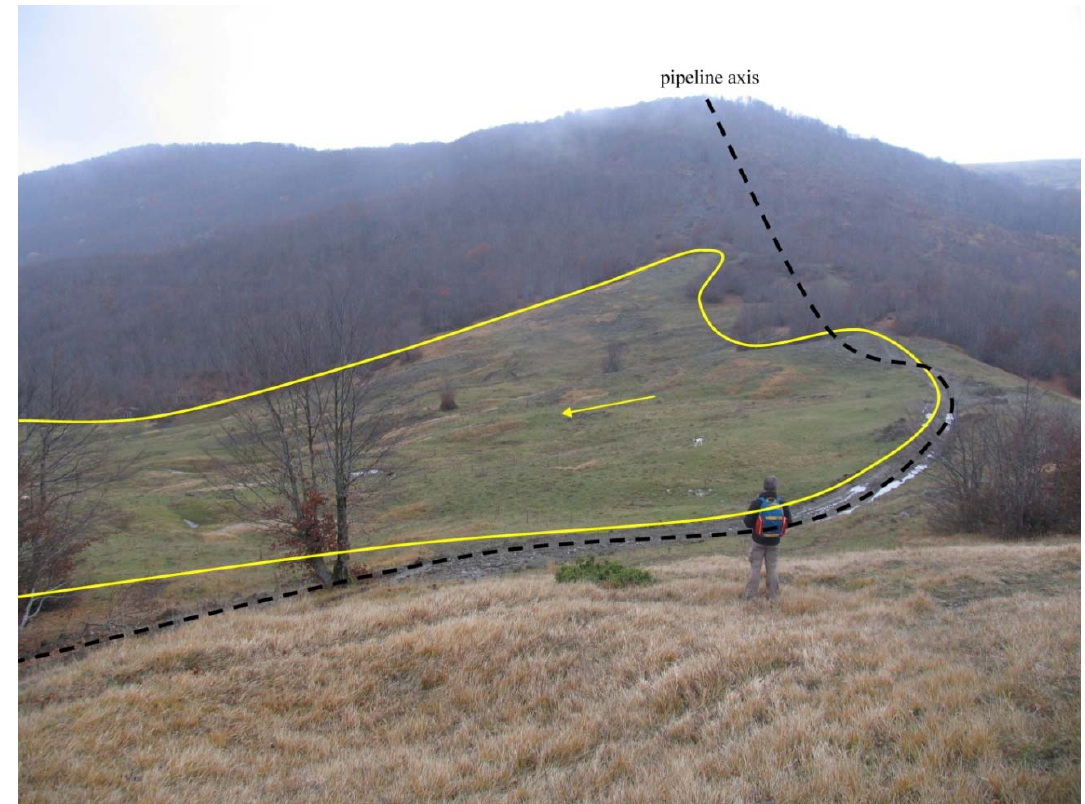
Figure 19. View of the slope at the location of ALS ‐ 14AB (Figures 9 and 13). The yellow line indicates the landslide boundaries (arrow pointing towards sliding direction), whereas the black line represents the position of the TAP pipeline axis.